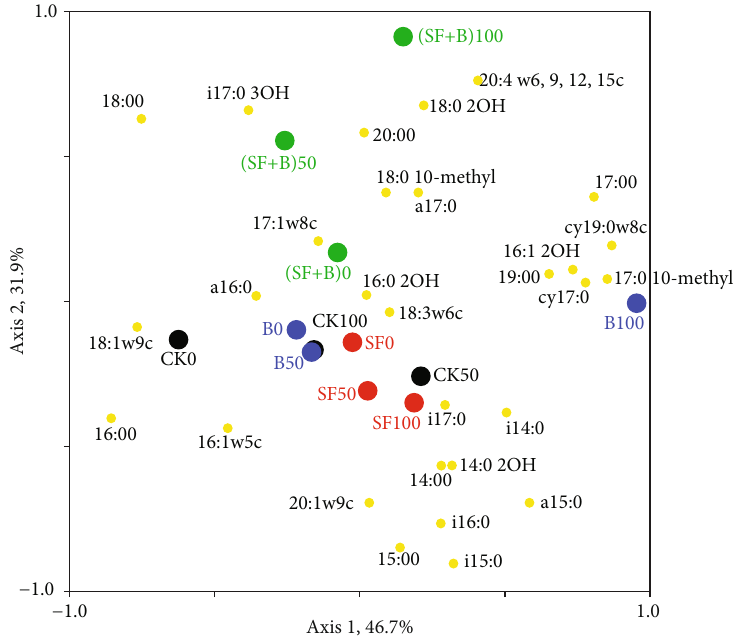
Figure 5: Principal component analysis of soil microbial communities based on PLFA biomarkers under di ff erent treatments. CK: control group; SF: silicon fertilizer, B: biochar; SF+ B: silicon fertilizer and biochar. Numbers 0, 50, and 100 represent the number of days of sampling,